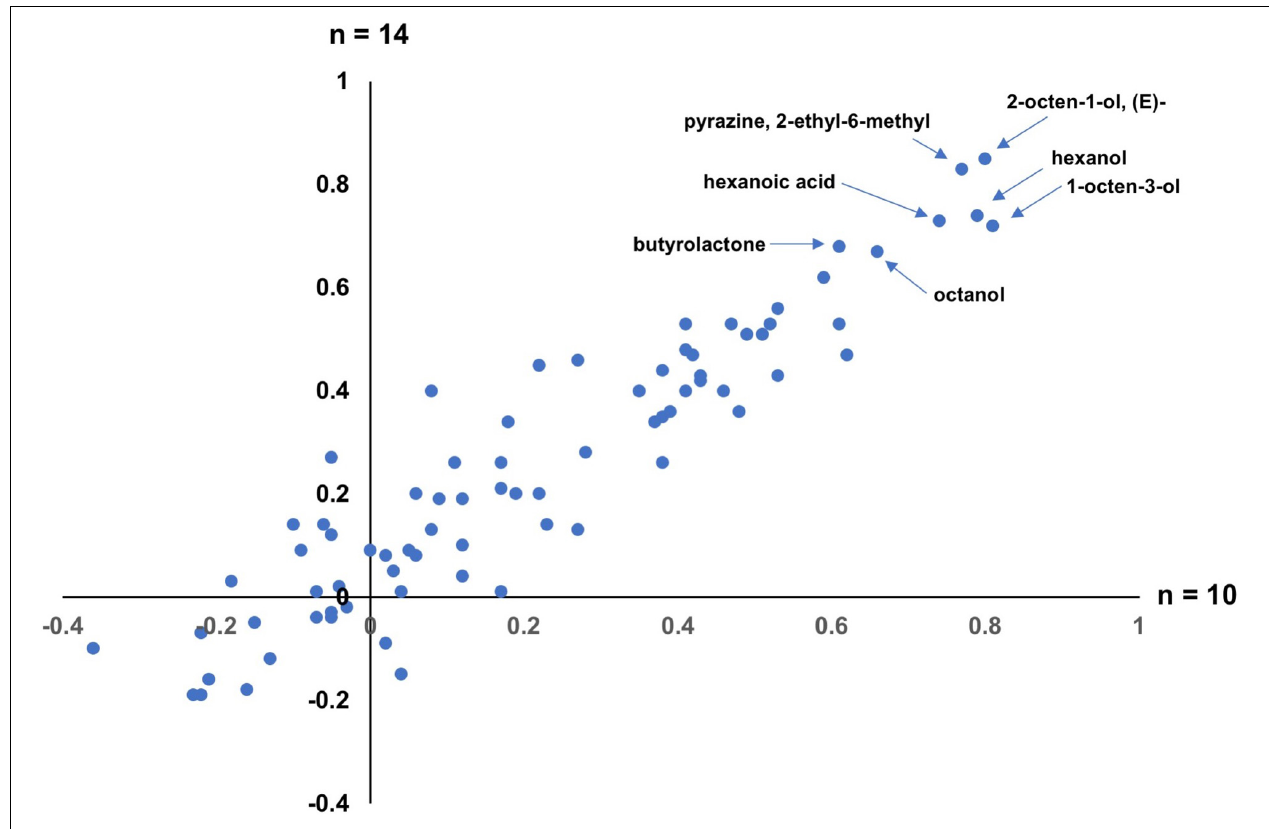
FIGURE 2 | Estimates of broad-sense heritabilities ( H 2 ) for volatiles. The x -axis are the estimates for the n = 10 clonal pair set and the y -axis for the n = 14 clonal pair set. Volatiles with high H 2 estimates are highlighted. The three volatiles whose estimates do not correlate well between clonal sets (2-pyrrolidinone, benzyl alcohol, 2,4-heptadienal, (E,E) − ) are not